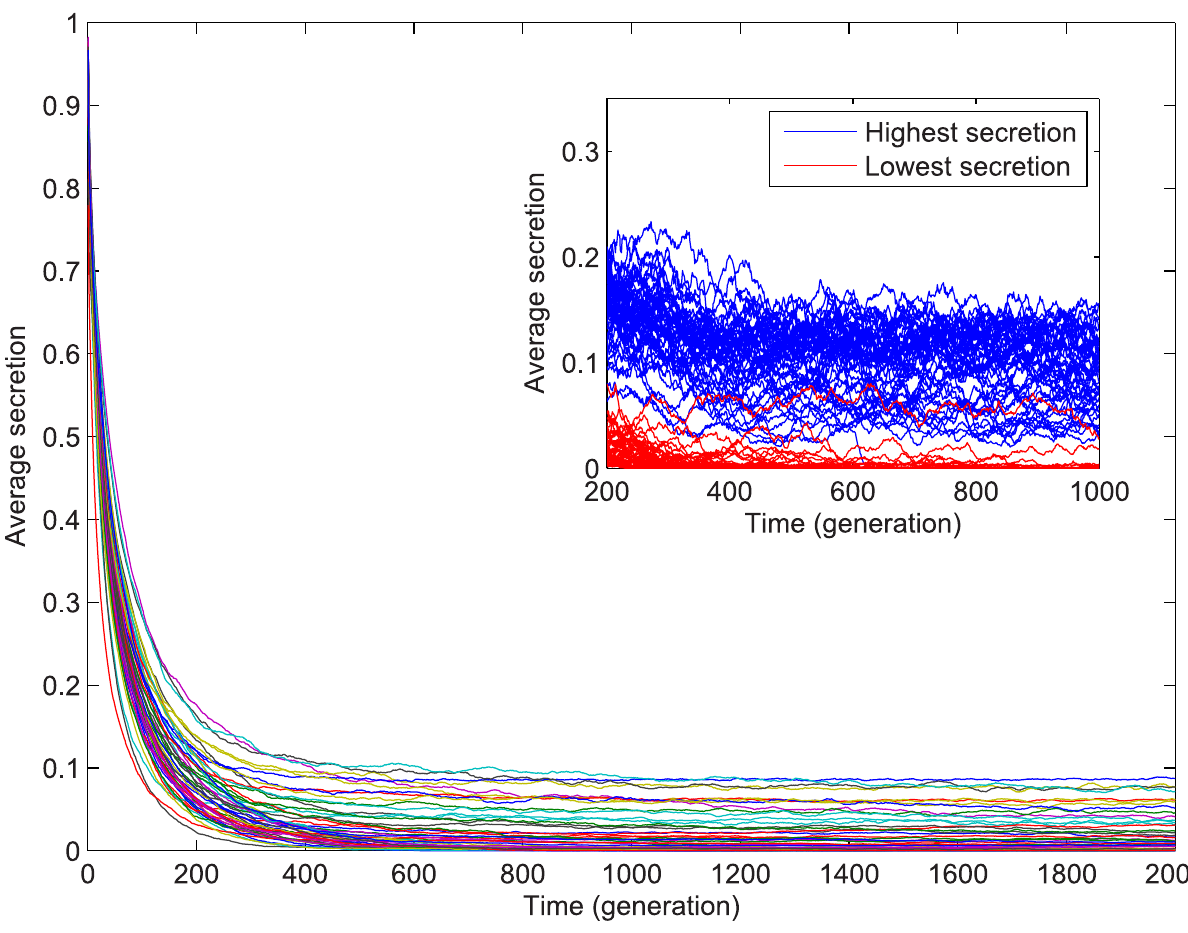
Figure 1. Cheater invasion dynamics in phenotypically similar starting populations. In the main figure each line represents the average secretion, over time, of 50 replicate populations started from the same ancestor. For clarity, we did not include the standard error of each group of replicate populations. The insert figure shows all 50 replicate populations for the two most extreme population groups, zoomed in on the time period of interest for our analyses. Specifically, of all the population groups sharing a common ancestor, the blue populations had the highest and red the lowest average secretion between generation 200 and generation 1,000 . Note that average secretion in the inset represents the average secretion within each population, whilst in the main figure it is the average of the secretion of all the individuals from the 50 replicate populations that share the same ancestor.